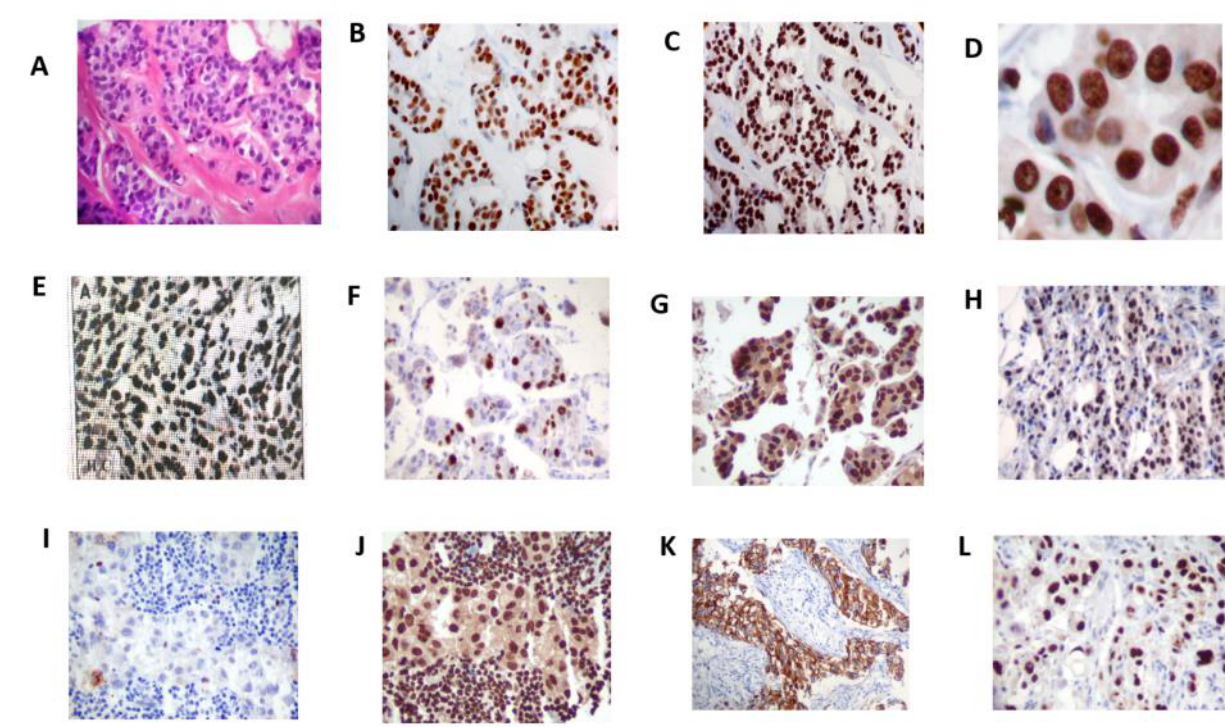
Figure 2. H&E stains of infiltrating duct carcinoma ( A ); immunohistochemistry stains of ERα ( B ) showing positive nuclear reaction only in neoplastic epithelial cells; ERβ expression ( C ) exhibiting strong and diffuse immunoreaction of the nuclei of neoplastic epithelial cells and stromal cells (original magnification × 20) ( D ); diffuse and intense staining of ER β expression in the nuclei (original magnification ×40); differential expression of ERβ in breast cancer types; ILC ( E ), infiltrating lobular carcinoma; APO ( F ), apocrine carcinoma; MIC ( G ), micropapillary carcinoma; MUC ( H ), mucinous carcinoma. ER α -negative BCa ( I ) showing high ER β expression ( J) ; co-expression of ER β with high Her-2/neu positivity ( K ) and high P53 expression ( L ). Original magnification ×20.